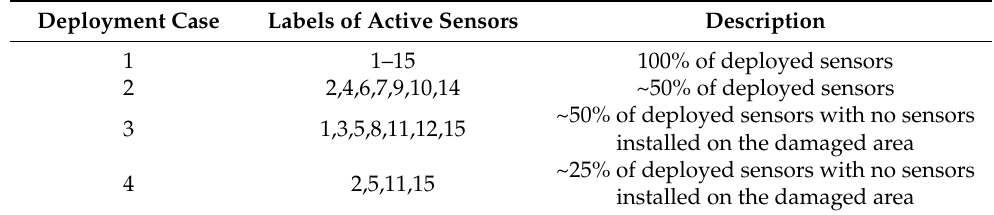
Table 2. Considered sensor deployment scenarios.